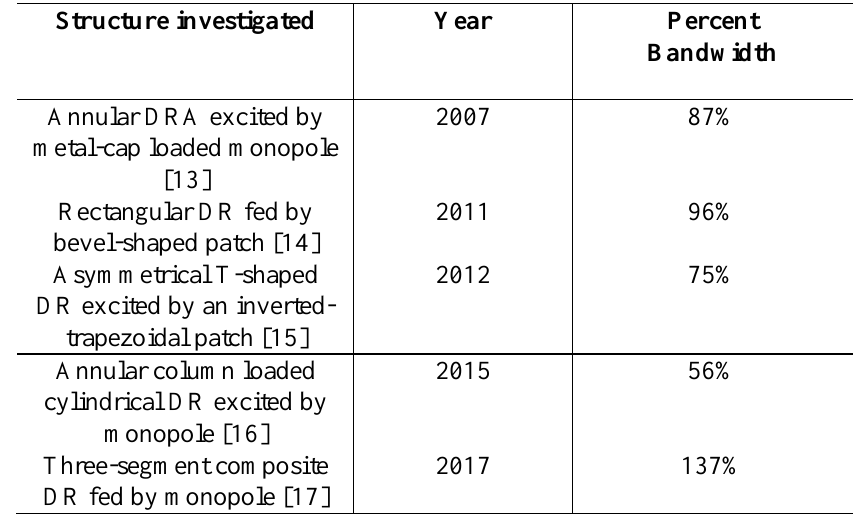
Table 1: Ultra-wideband hybrid DRAs reported in the